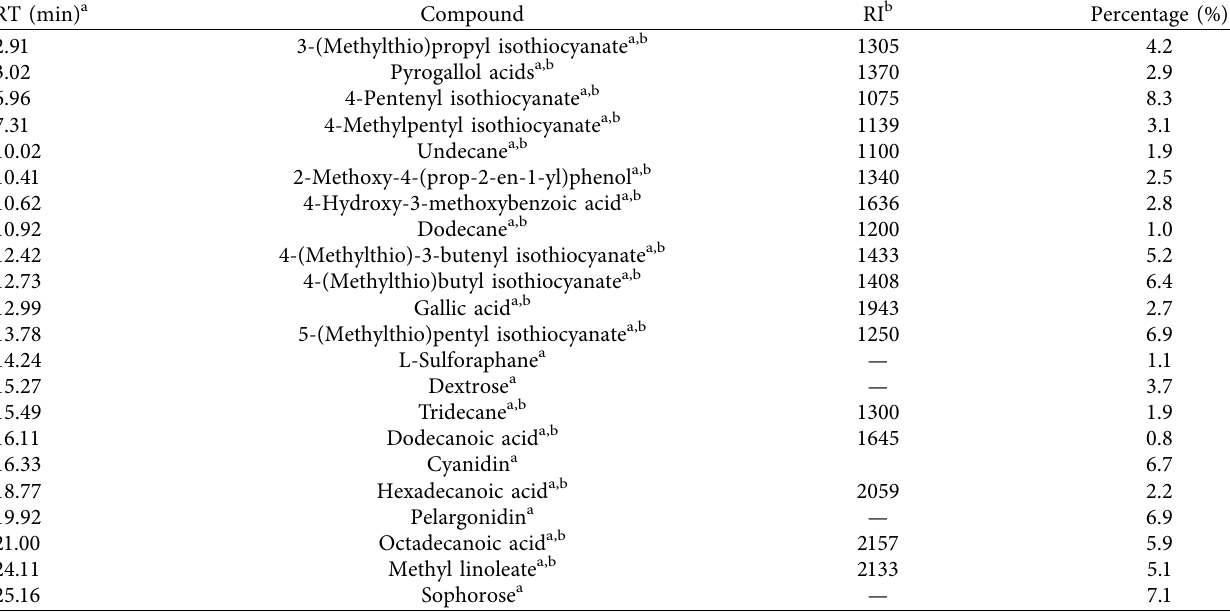
Table 1: GC-MS analysis results of radish cake extract.